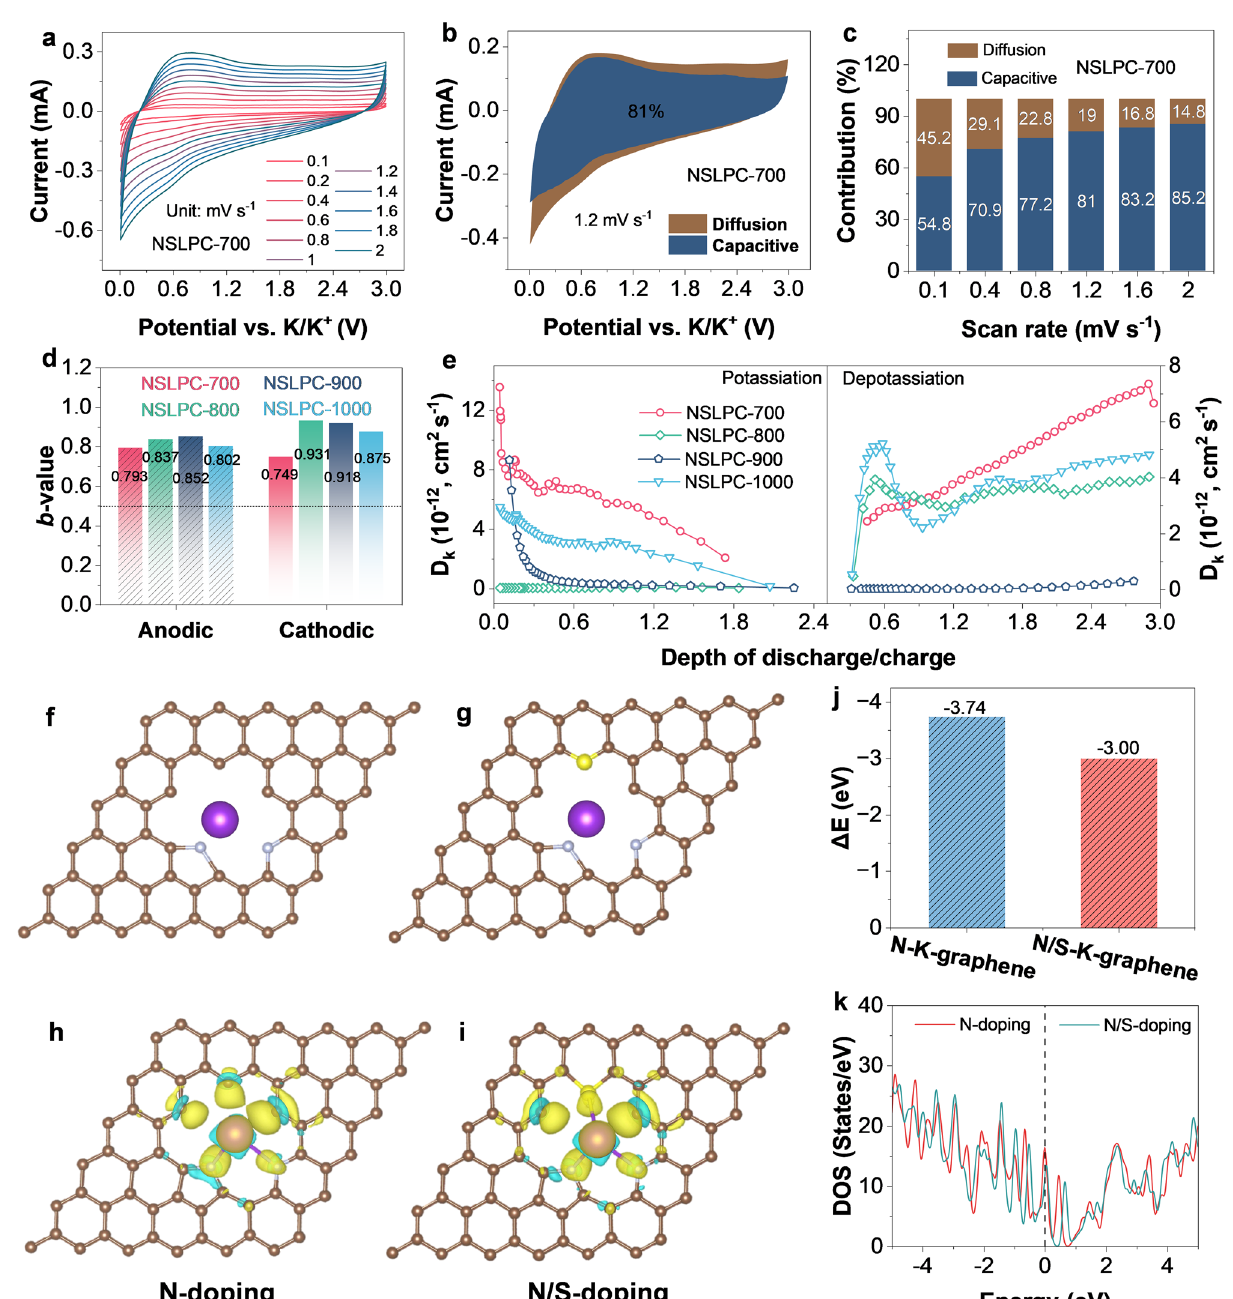
Fig. 6 a CV curves of the NSLPC-700 anode at different scan rates. b Capacitive contributions of NSLPC-700 anode at a scan rate of 1.2 mV s −1 . c Capacitive contributions of NSLPCs anode as a function of scan rate. d Comparison of b values of NSLPC samples. e K + diffu- sion coefficient of NSLPCs obtained via the GITT technique during depotassiation and potassiation processes. Front views of optimized models with a single K adsorbed on the f N-doped, g N/S-doped defective graphene sheet and their corresponding j binding energy (ΔE). h, i Calculated difference charge density of K adsorbed onto different structures. k Density of states (DOS) of the N-doped, N/S-doped